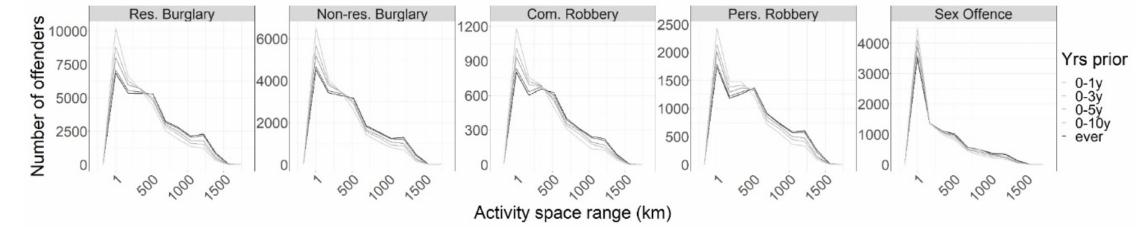
Figure 3. Distribution of activity space range per offender by reference offense type and timeframe preceding the reference